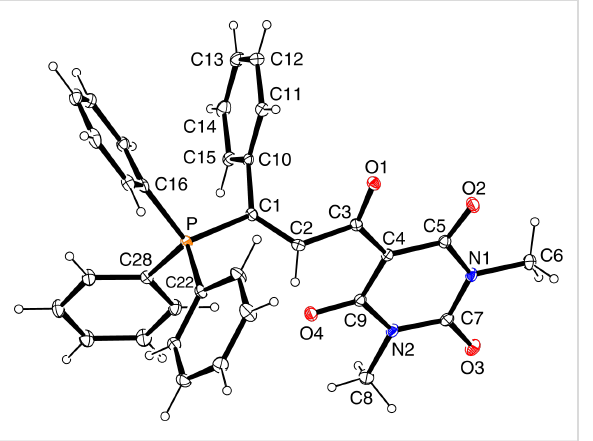
Figure 3: Solid-state structure of E - 3b ·CH 2 Cl 2 (ORTEP plot); CH 2 Cl 2 solvate molecule not shown.